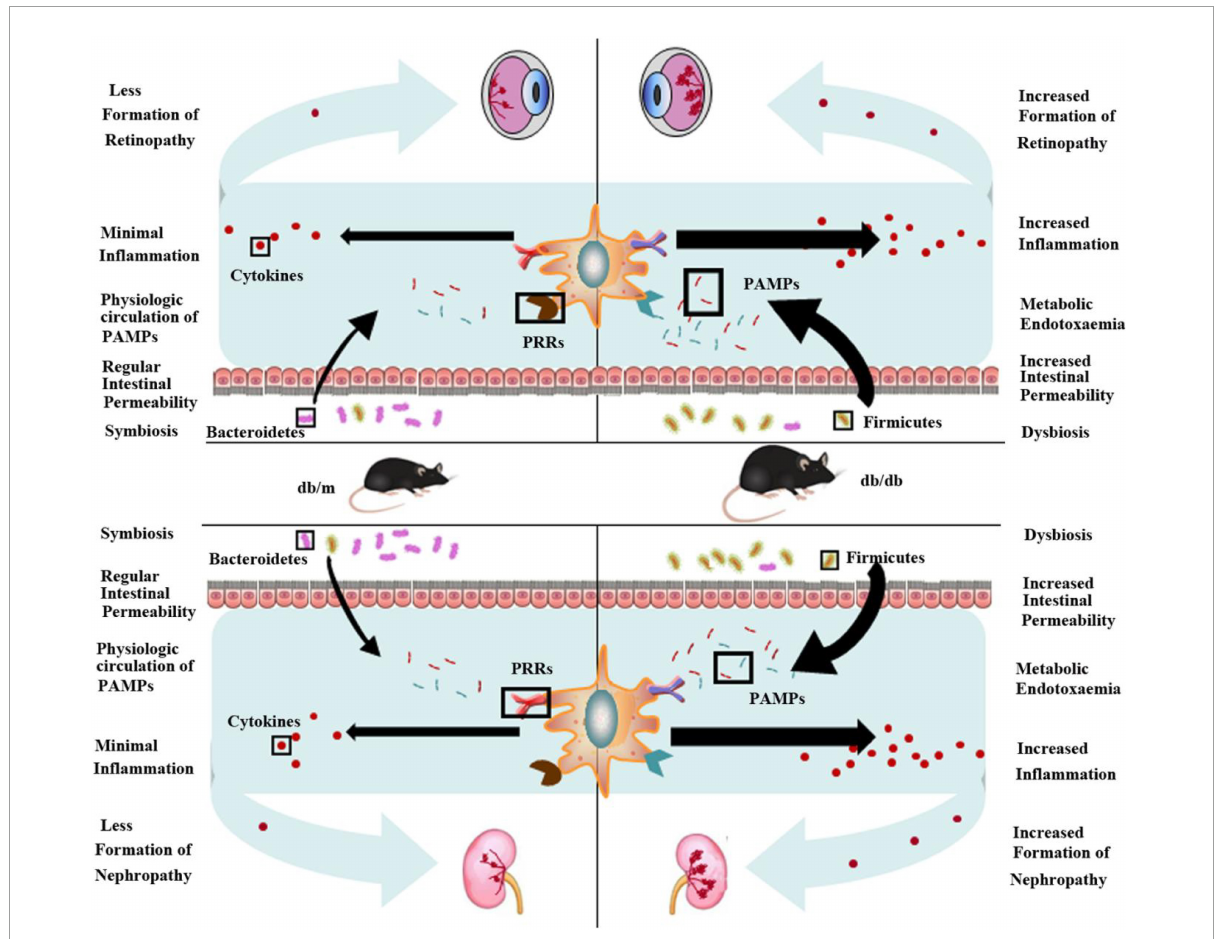
FIGURE7 Obesity-induced gut microbiota dysbiosis increases intestinal permeability, metabolic endotoxemia, and systemic and local inflammation and ultimately contributes to retinopathy and nephropathy. The ratio of two dominant phyla in intestinal flora, Bacteroidetes and Firmicutes significantly decreases in obesity (db/db) mice compared to normal (db/m) mice, with a relative increase in Firmicutes in obesity mice and decrease in Bacteroidetes. This dysbiosis is accompanied by heightened intestinal permeability, which allows increased translocation of pathogen-associated molecular patterns (PAMPs) (endotoxemia). Recognition of these microbe-specific molecules by pattern recognition receptors (PRRs) present on innate immune cells triggers synthesis and excretion of cytokines causing chronic systemic low-grade inflammation. Ultimately, this exacerbates retinopathy and